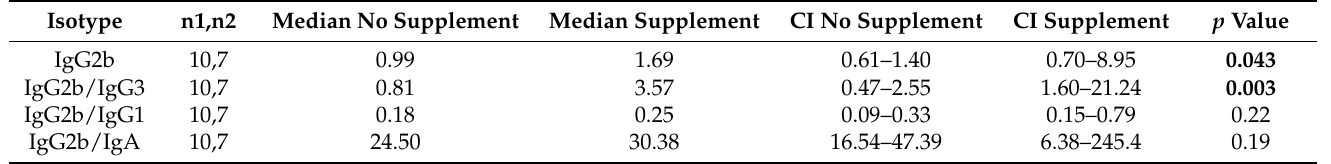
IgG2b results from Figure 3, including animal numbers (n1 for unsupplemented, n2 for supplemented), medians, and CI values, are tabulated. p values are bolded when p < 0.05 for the comparison between groups (Mann–Whitney test).